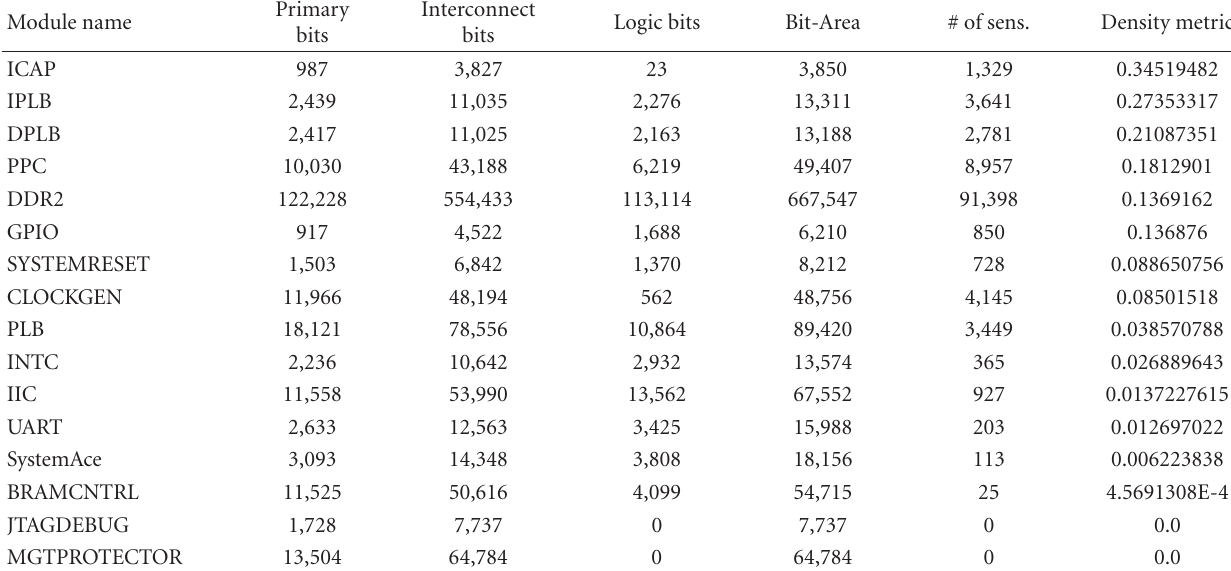
Table 6: Comparison of